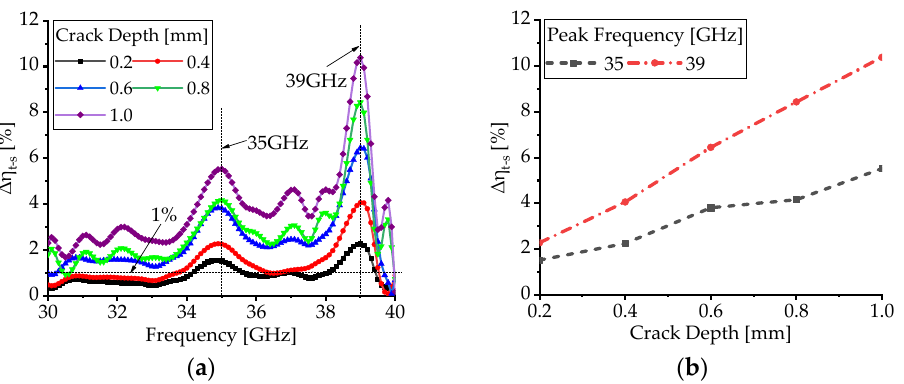
Figure 7. Simulation results of cracks of different depths in 30–40 GHz bands. ( a ) Corresponding to different values of d, the relationship between ∆ η t − s and frequency when w = 1 mm, l = 100 mm, and θ = 0°. ( b ) The relationship between ∆ η t − s and d at different peak frequencies when w = 1 mm, l = 100 mm, and θ = 0°.